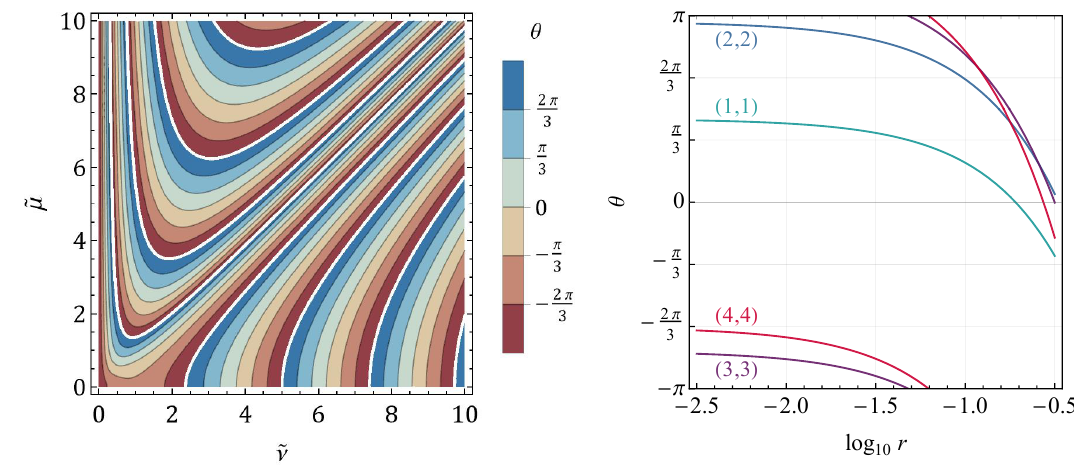
Figure 11 . The phases θ T ( r, r ) of the nonlocal signal from the s-channel 1-loop exchange of a massive spin-1 boson. The left panel shows the phase in the squeezed limit r → 0 as a function p of mass parameter ν = m 2 /H 2 − 1 / 4 and the chemical potential e coupling. The right panel shows the phases from time-derivative coupling as functions of momentum ratio r for several choices of ( µ, ν ) e e